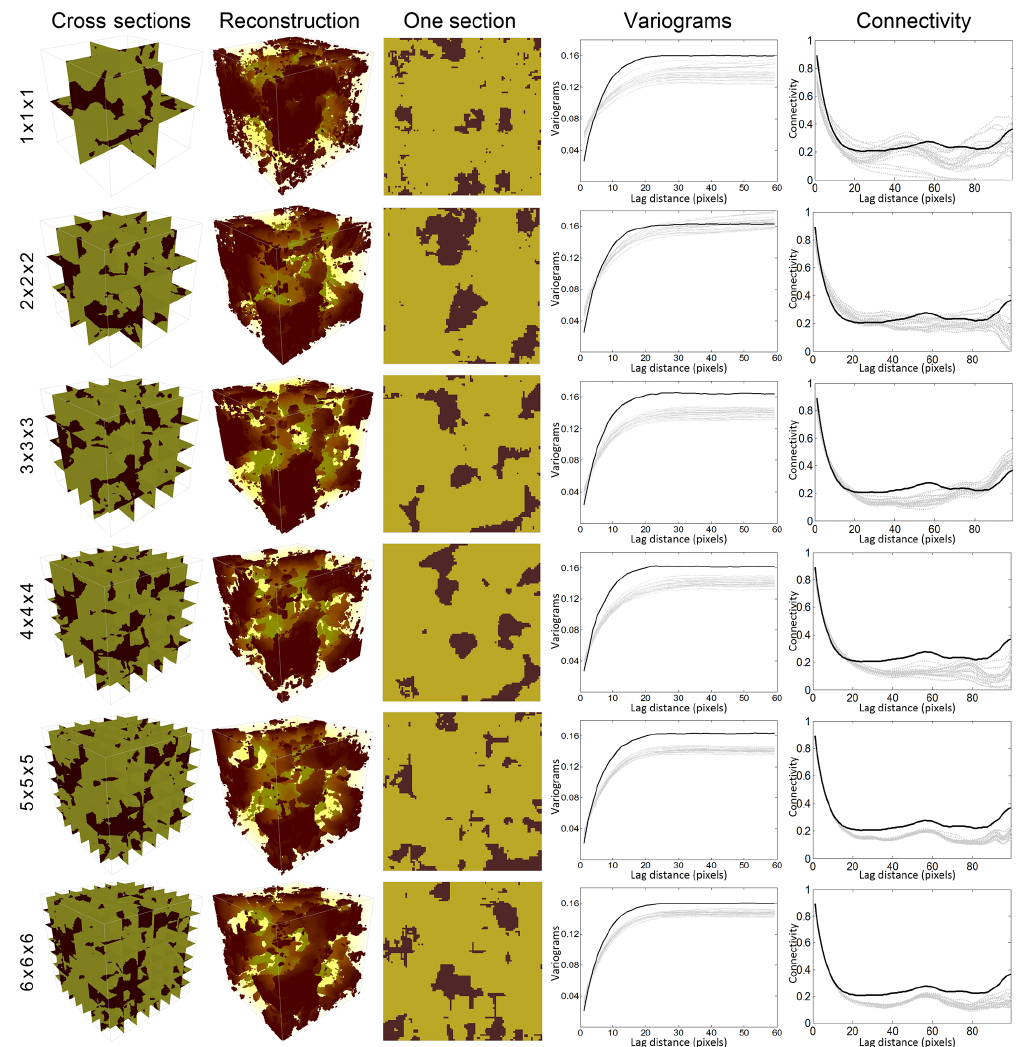
Figure 5. Reconstructions and their statistical properties when increasing the number of sections in each direction. The first section along x direction of a reconstruction for each case is presented here. We only present the connectivity functions computed along the coordinate y since their features are similar in three directions. The black lines represent the corresponding features of the reference models, and the gray lines represent the features of the